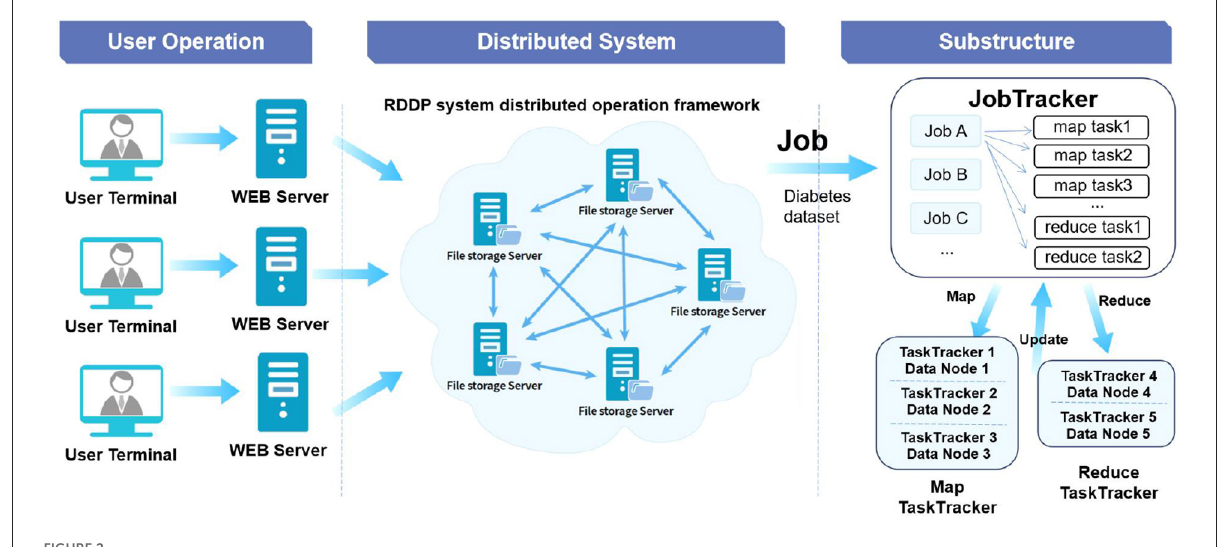
FIGURE2 RDDP system distributed storage